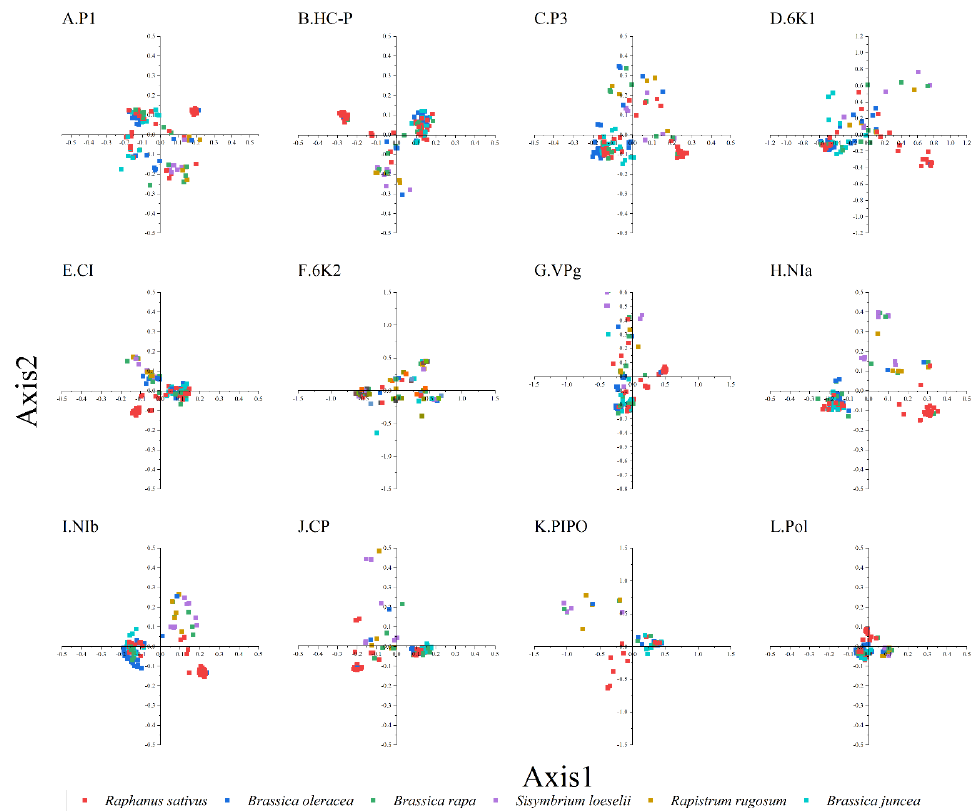
Figure 1. Principal component analysis (PCA) is based on the relative synonymous codon usage (RSCU) values of the 59 synonymous codons for the individual protein ( A − K ), complete polyprotein ( L ), and coding sequences of turnip mosaic virus. The Raphanus sativus, Brassica oleracea, Brassica rapa, Sisymbrium loeseli, Rapistrum rugosum and Brassica juncea hosts are represented in red, blue, green, purple, orange, wathet blue and brown, respectively.